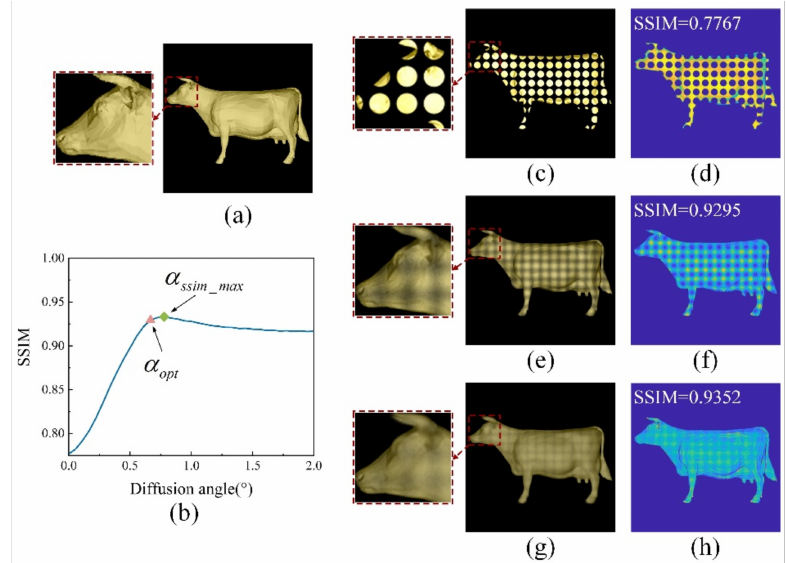
Figure 5. Simulations of different diffusion angles of the 3D scene: ( a ) image of the cow model taken directly by the virtual camera; ( b ) simulation of the relationship between the diffusion angle of the HFS and the SSIM value; ( c ) simulated reconstructed result without the HFS; ( d ) SSIM corresponding to the reconstructed result in ( c ); ( e ) simulated reconstructed result using the HFS with the optimal diffusion angle α opt ; ( f ) SSIM corresponding to the reconstructed result in ( e ); ( g ) simulated reconstructed result using the HFS with the max SSIM value diffusion angle α ssim _ max ; and ( h ) SSIM corresponding to the reconstructed result in ( g ).